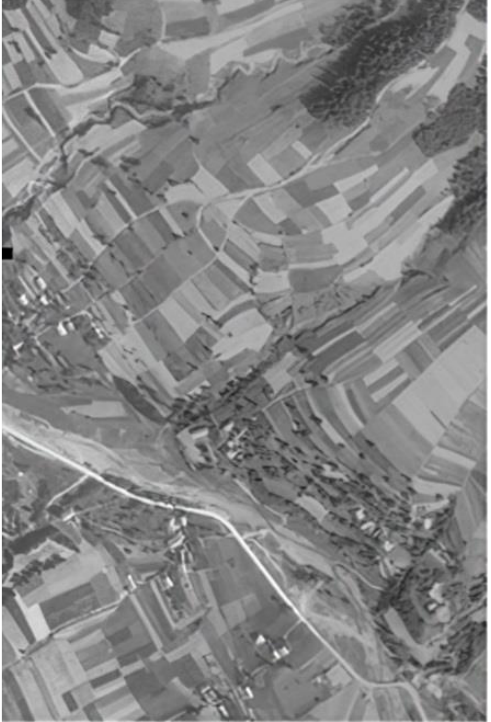
Figure 5. Orthophotomap from 1963.